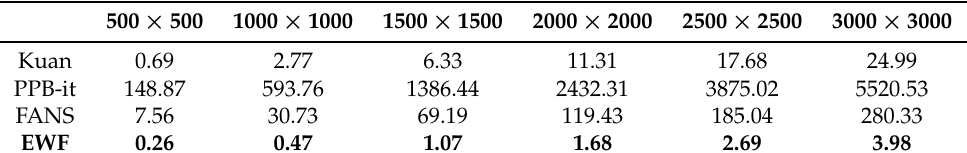
Table 5. Processing time elapsed by the filters (in seconds) while varying the Chicago City data patch size.